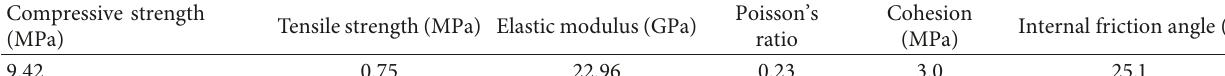
Table 3: Rock mechanics parameters for numerical simulation.